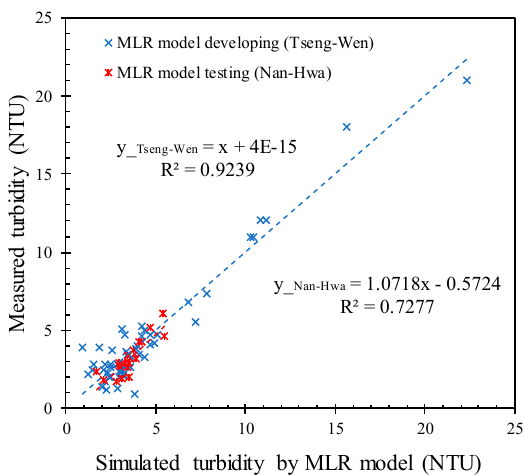
Figure 6. The relationship of observed turbidity and multiple linear regression (MLR) simulated turbidity in Tseng-Wen and Nan-Hwa reservoir.